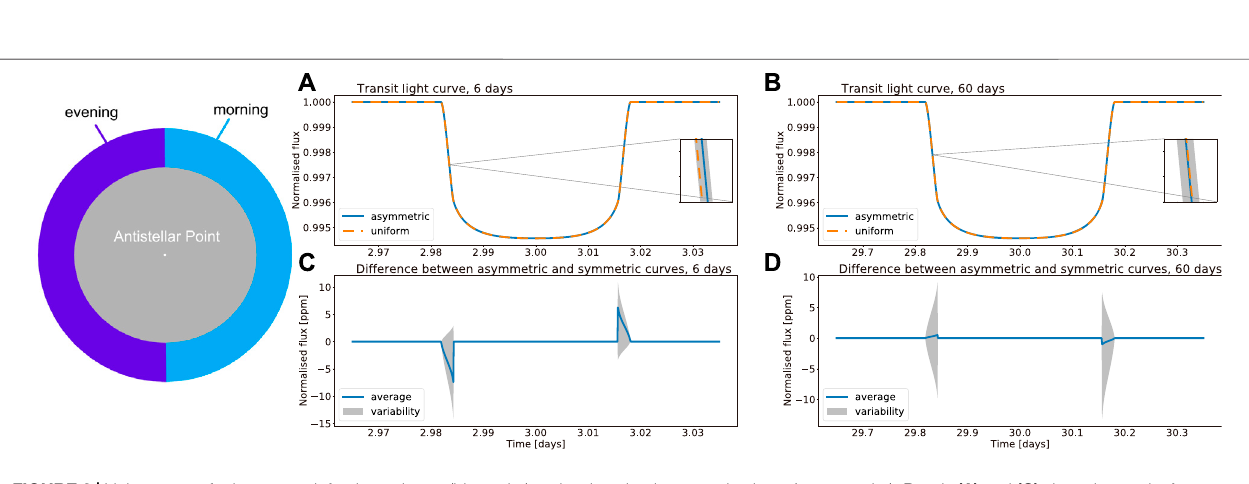
FIGURE 8 | Light curves of primary transit for the real case (blue color) and an imagined symmetric planet (orange color). Panels (A) and (C) show the results for planets with arotation period ofsix Earth days. Panels (B) and (D) show the results for planets with arotation period of60 Earth days. The lines are the mean values and the gray shading represents the variability. (C) and (D) are for the differences between the real case and the imaged symmetric planet. The light curves were calculated using the module PyTransit, a fast exoplanet transit model written in Python (Parviainen, 2015), and the light curves are summed over 0.6 – 5 μ m, the same as the spectral range of transmission spectra in Figure 2